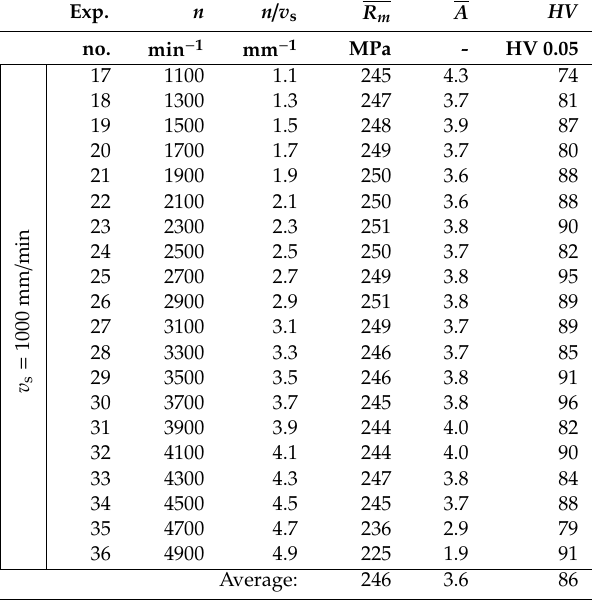
Table A2. Welding experiments performed and mechanical properties achieved for a welding speed v s of 1000 mm / min.